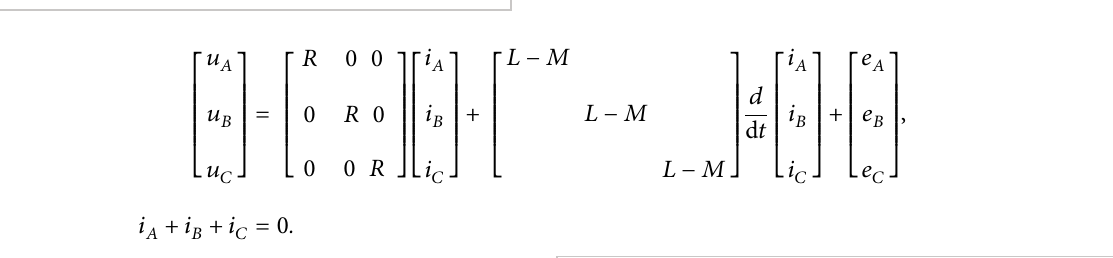
motor phase resistance ( Ω ); L is self-inductance of each phase winding (H); and M is the mutual inductance between each two-phase winding